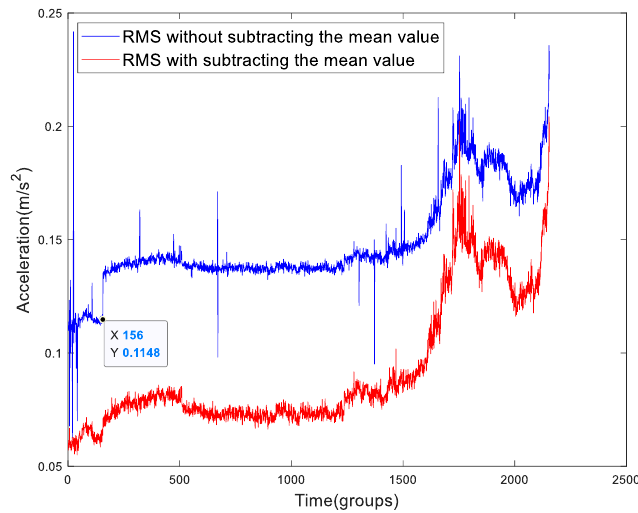
Figure 4. The Bearing1-4IMS’s RMSs with and without subtracting the mean value.